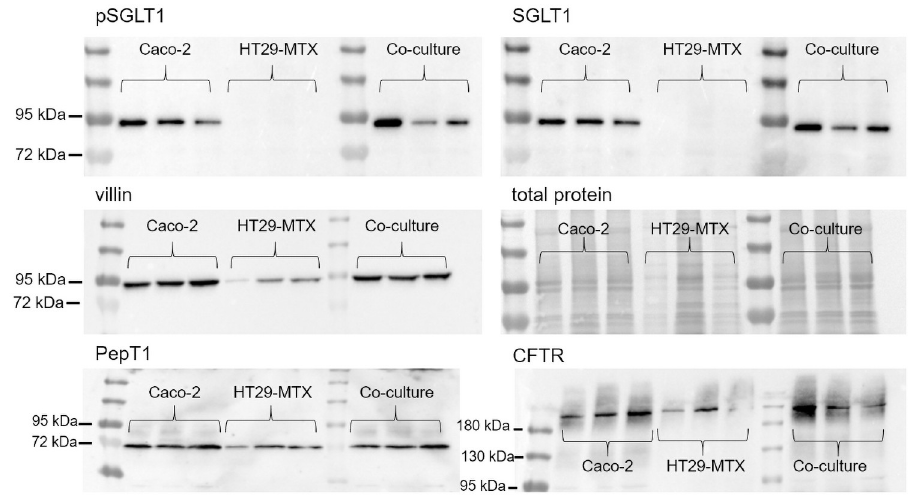
Fig 8. Protein expression of pSGLT1, SGLT1, villin, total protein content, PepT1 as well as CFTR in Caco-2, HT29-MTX and co-cultured Caco-2 and HT29-MTX cells. pSGLT1 and SGLT1 were blotted on the same membrane, which was stripped after incubation with the pSGLT1-antibody. Each lane on each membrane represents a biological replicate, experiments were performed in triplicates.